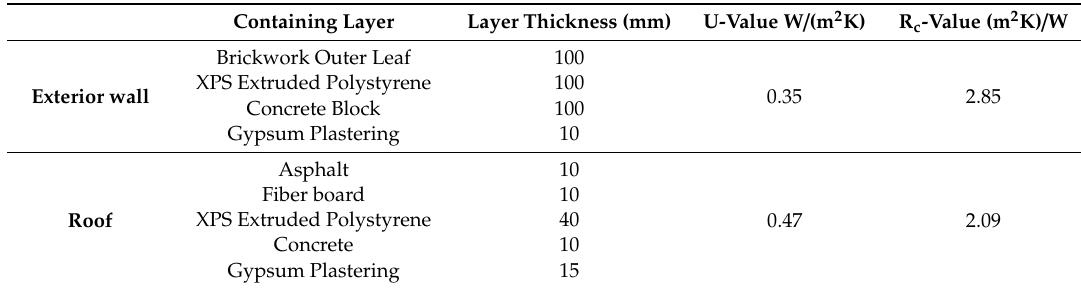
Table 3. The building materials simulated in the DesignBuilder software derived from the Energy Plus software library, based on the ASHRAE standard